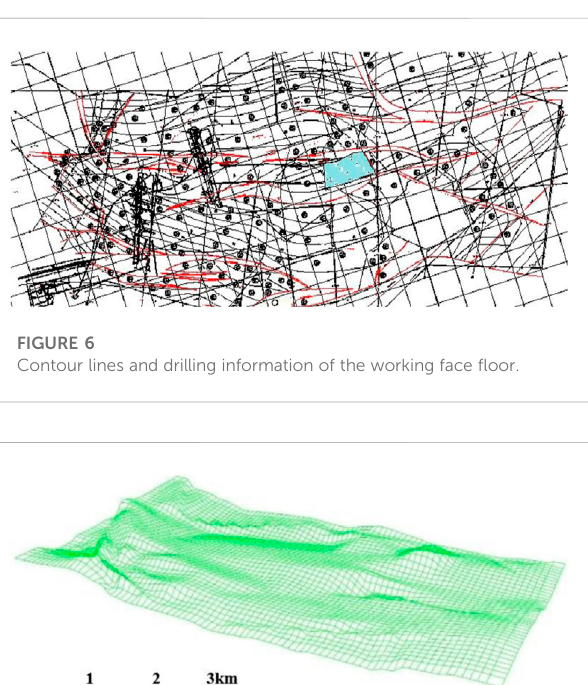
FIGURE 7 The mesh model of the working face fl oor.